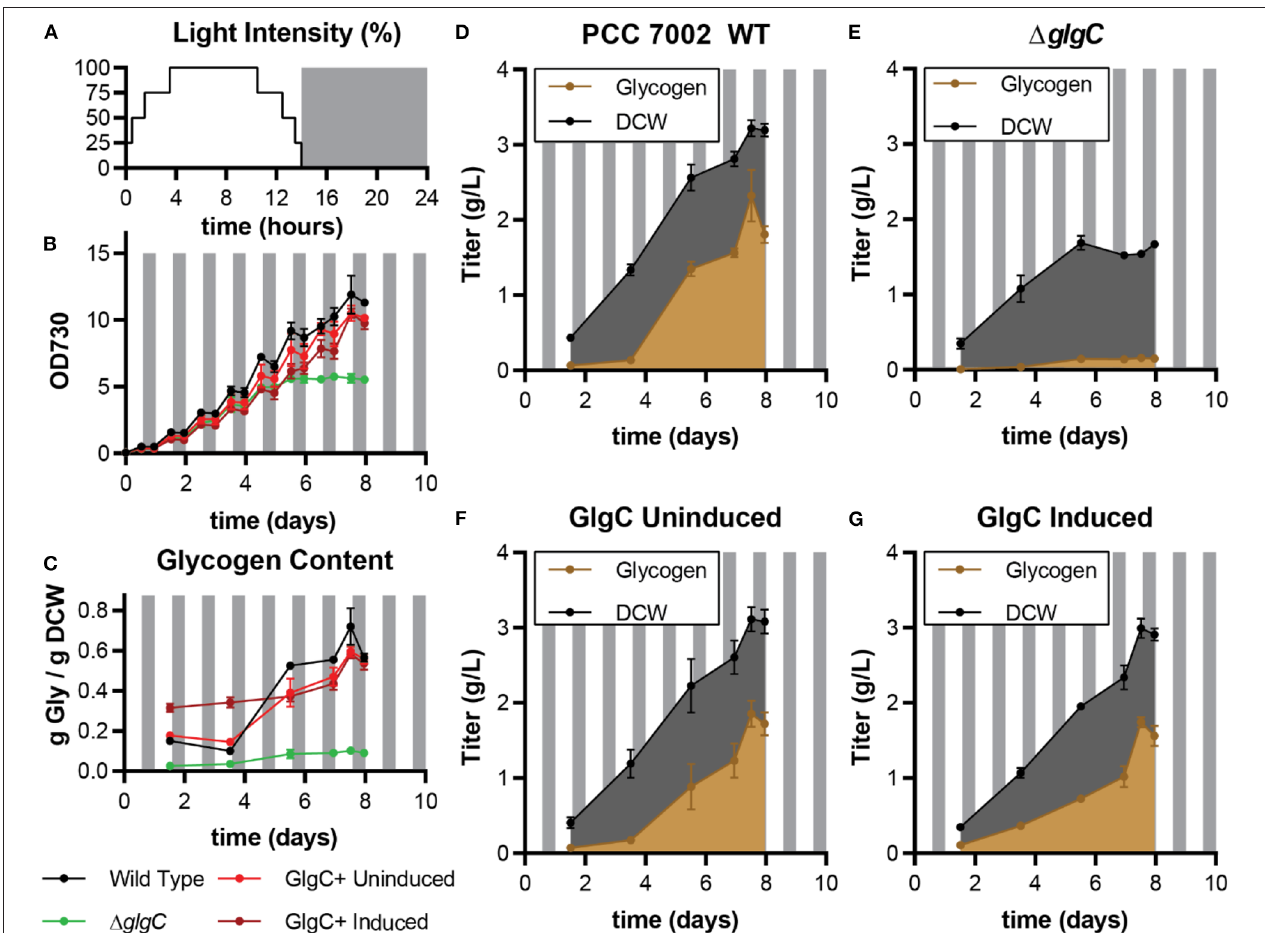
FIGURE 3 | Biomass and glycogen production by PCC 7002 strains under diurnal light conditions in media A. (A) Diurnal light intensity was programmed as an 8-step variation with each step varying the fraction of maximum light output. (B) Shows the biomass production measured optical density at 730nm. (C) Reports the fraction of the total dry cell weight that was glycogen over time. (D–G) Show the titer of glycogen (brown) and total DCW (black) over time for each of the four listed cultures. Each culture was performed in triplicate. Error bars represent standard deviation.